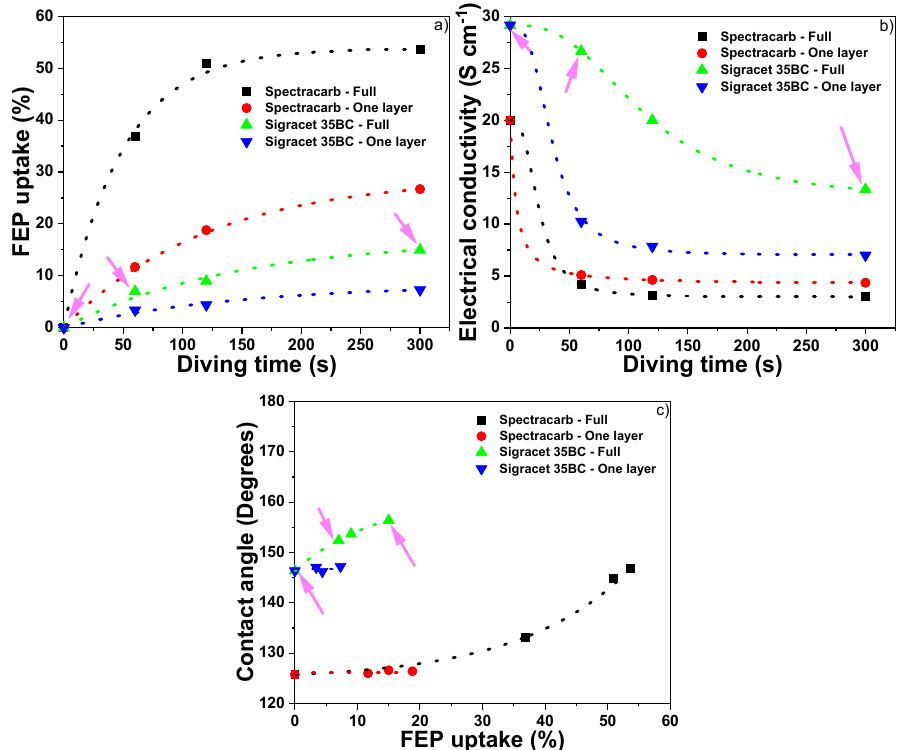
Figure 1. FEP uptake vs immersion time ( a ), electrical conductivity vs immersion time ( b ), contact Figure 1. FEPuptakevsimmersiontime( a ), electricalconductivityvsimmersiontime( b ),contact angle top angle top layer vs immersion time ( c ) of different gas diffusion layers under different layer vs immersion time ( c ) of di ff erent gas di ff usion layers under di ff erent hydrophobisation conditions. hydrophobisation conditions.